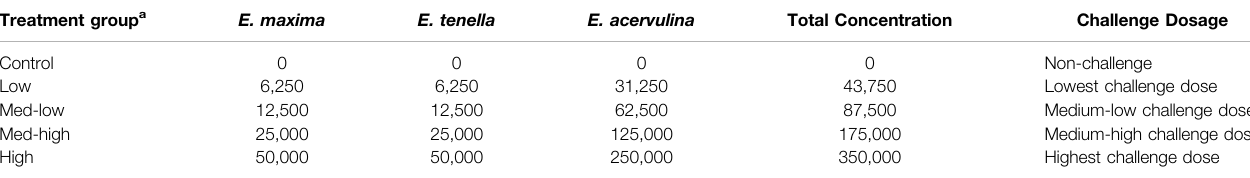
TABLE 1 | Eimeria spp. challenge dosage (Unit: oocysts/chick). Treatment group